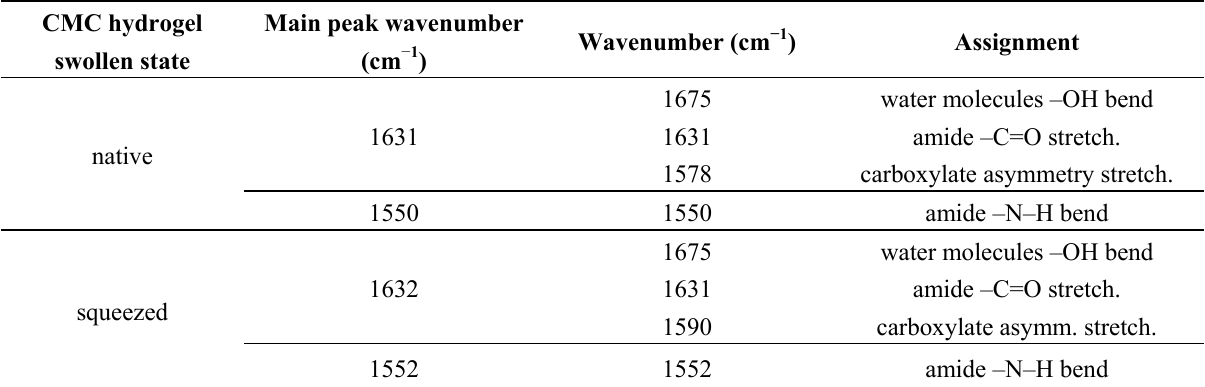
Table 4. Assignment of bands of spectra for CMC hydrogels ( a ) native and ( b ) squeezed in swollen state present in the region between 1700 and 1500 cm − 1